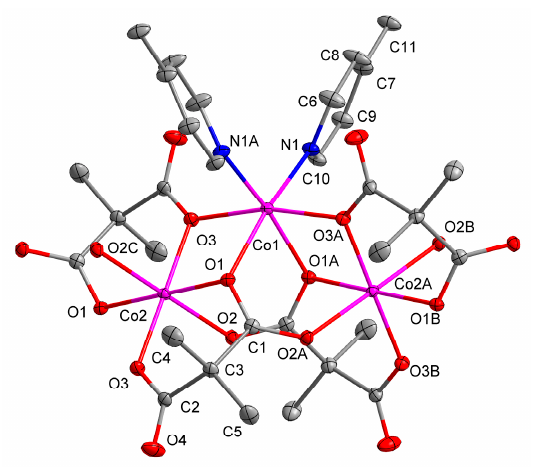
Figure 4. The metal coordination environments of compound 2 . The H atoms have been omitted for clarity. [Symmetry code: (A) 1 − x, y, 1.5 − z; (B) x, 1 − y, − 0.5 + z; (C) 1 − x, 1 − y, 2 − z].